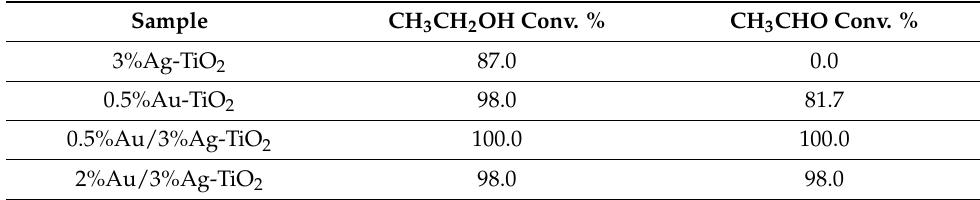
Table 1. Ethanol conversion and acetaldehyde conversion after 3 h of UV irradiation. Sample